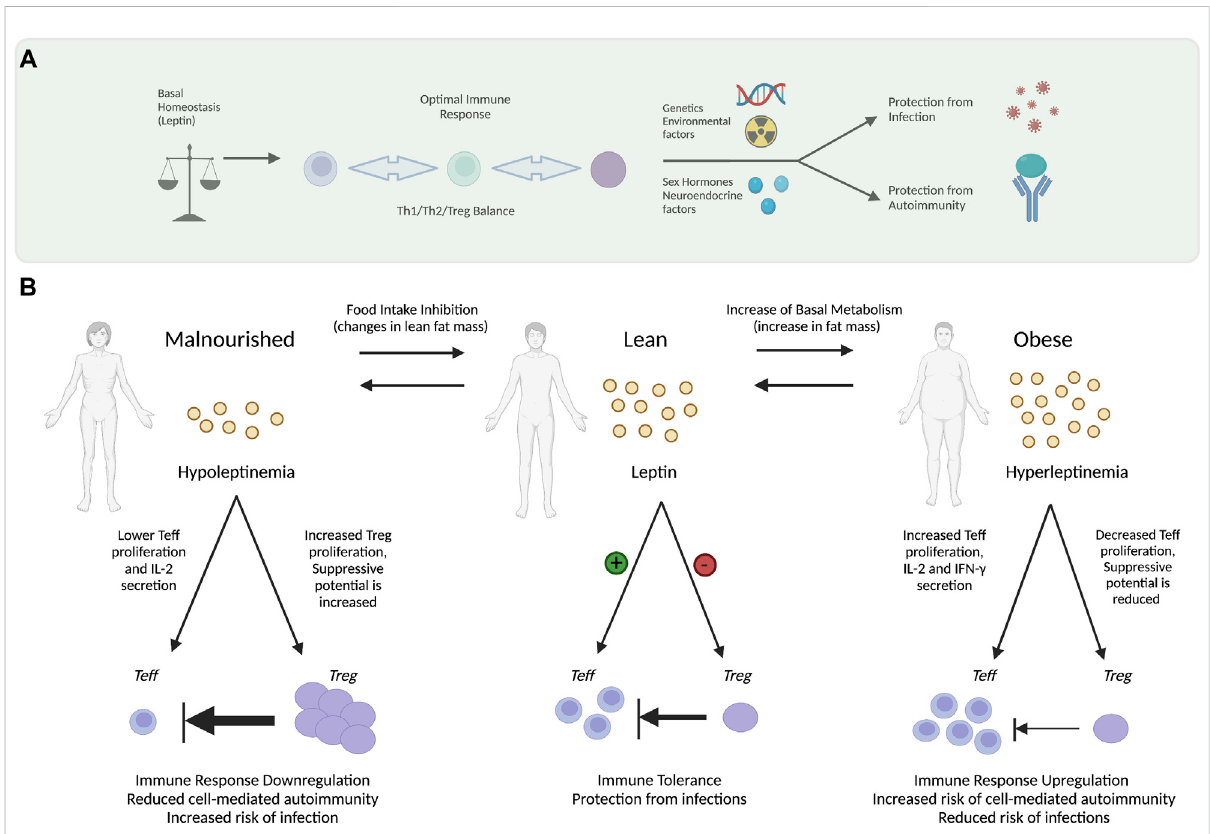
ModulationofTh1CellAutoimmunitybyLeptin.LeptinservesasamodulatorofTh1cellautoimmunitybyitsactiononeffectorTcells(Teff)and regulatory T cells (Treg). (A) Under basal conditions, homeostatic mechanisms govern leptin levels tuning them for optimal immune responsiveness with the appropriate balance of Th1/Th2/Treg cells that protect from infection but prevents autoimmune disease development. Numerous factors can in fl uence the immune response including genetic factors, environmental triggers that damage DNA, tissue, and immune cells. Neuroendocrine factors such as sex hormones also play an immodulatory role. (B) Under homeostatic conditions (center) a lean metabolically healthy individual has relatively low levels of basal leptin secretion by adipocytes. In homeostasis — leptin secreted by adipocytes maintains the Th1 immunity in balance — promoting proliferation of Teff cells while inhibiting expansion of Treg cells. Maintaining the balance between Teff and Treg cells is important for preserving immune tolerance while also protecting against infections. The level of leptin promotes regulated immune function (medium inhibitory arrow) maintaining Treg cell and Teff at steady state levels. Under starvation conditions (left) individuals with substantial weight loss — leptin levels can become too low (hypoleptinemia), which reduces (thick inhibitory arrow) Teff proliferation while increasing Treg cell expansion. Low levels of leptin cause down-regulation of Th1 immunity thereby decreasing the incidence of cell-mediated autoimmune diseases while increasing susceptibility to infections. In obesity (right panel) adipose tissue mass expands and adipocytes express high levels of leptin — subsequently stimulating expansion of Teff cells (thin inhibitory arrow) with a concomitant reduction in Treg cells (thin arrow).